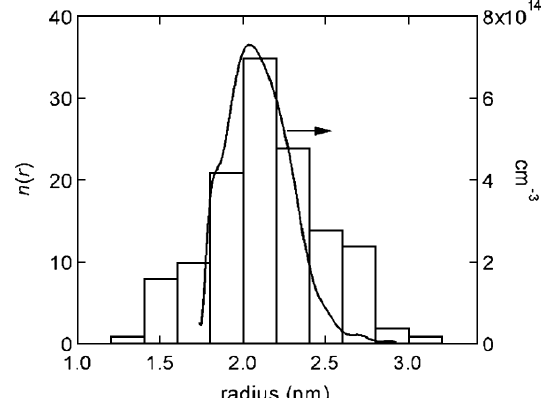
Fig. 5 (a) Absorbance spectrum for a (0001) ZnO single crys - tal and (b) absorbance spectrum for a suspension of ZnO quantum particles after 2 h of growth at 65 °C. The inset shows the spectrum for the ZnO single crys- tal plotted as ( Ahν ) ² versus hν . Reprinted with permis- sion from Pesika et al., “Relationship between Absorbance Spectra and Particle Size Distributions for Quantum-Sized Nanocrystals” J. Phys. Chem. B 2003